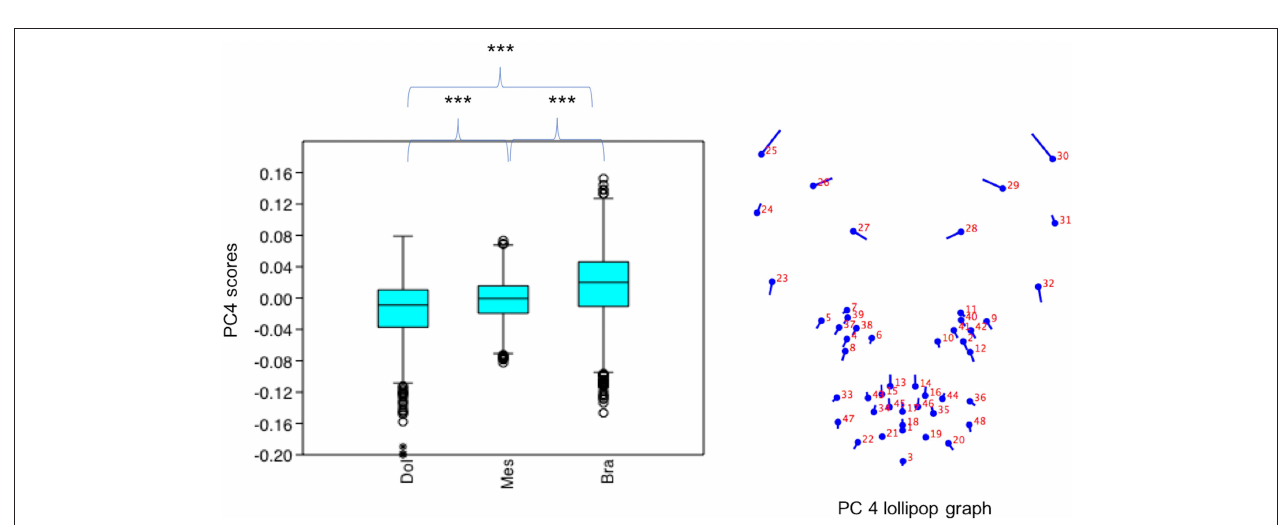
FIGURE 4 | Boxplot with minimum, first quartile, median, third quartile, maximum values and outliers for PC4 scores for each of the cephalic types; Dol, dolichocephalic; Bra, brachycephalic; Mes, mesocephalic; n = 1,888. *** p < 0.001. Relative landmark variation for PC4 represented via lollipop graph. Lines protruding from each landmark indicate direction and magnitude of movement, with higher PC4 scores reflecting a greater distance along the line from the circular nodes. Images produced using MorphoJ, Version 1.06d (57). All breeds within the brachycephalic group were significantly